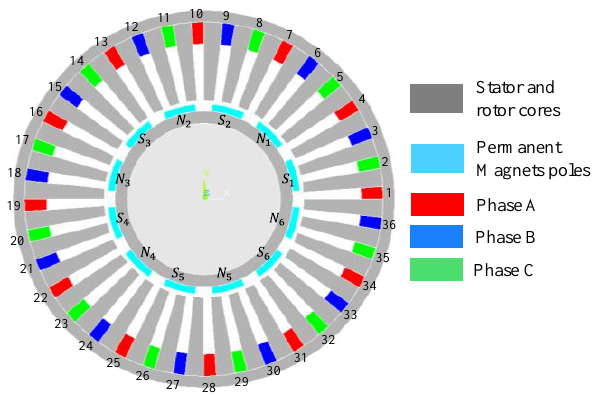
Figure 1. Laminated sheet of SPMM.